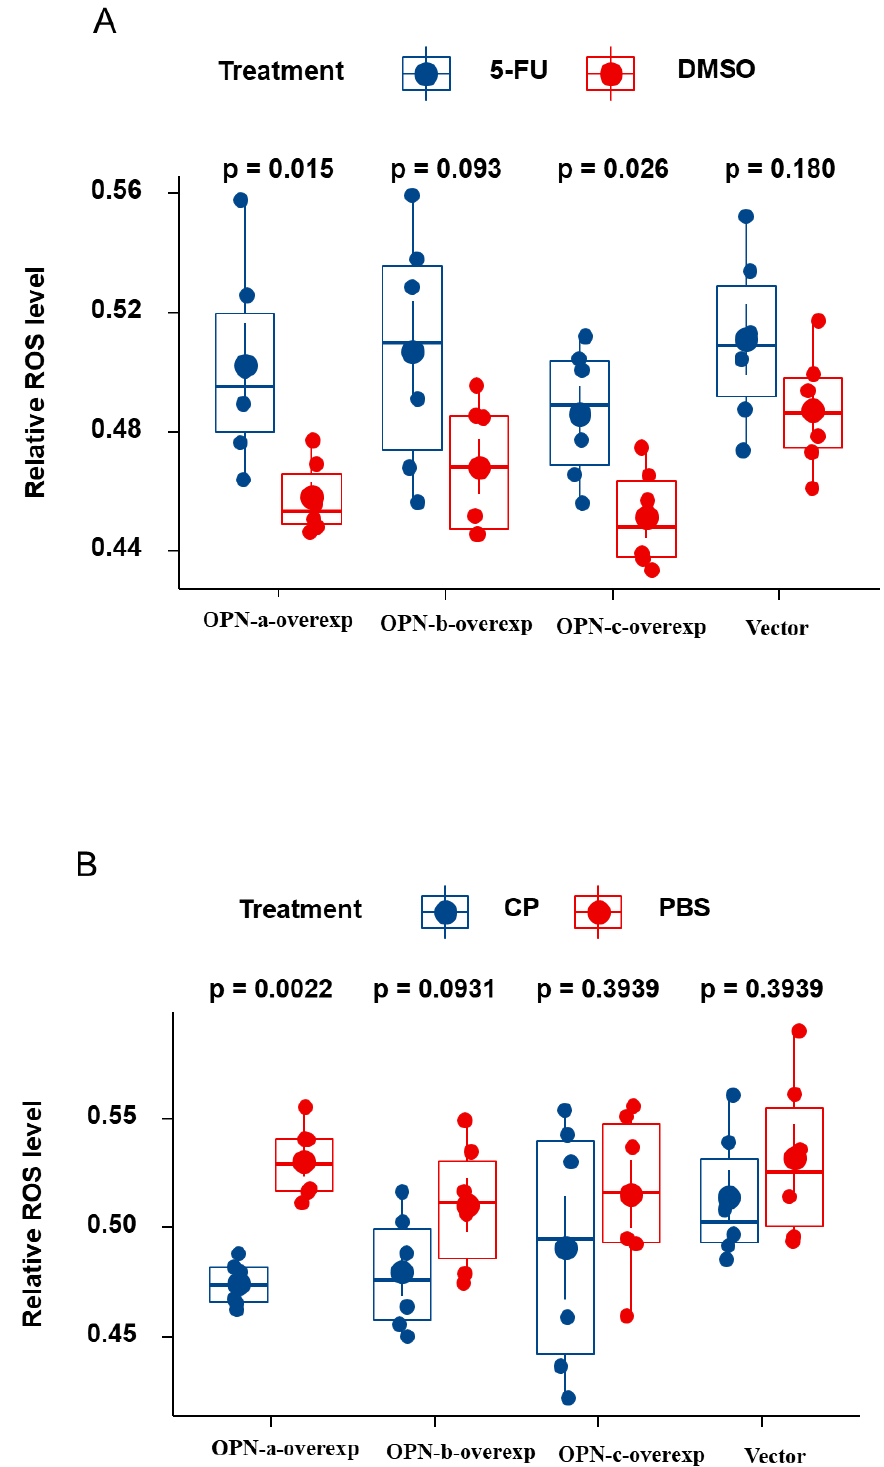
Figure 4. Effect of the OPN variants on the Cellular Reactive Oxygen Species (ROS) produced by gastric cells in response to chemotherapeutic drugs. ( A ) 5-Fu and its DMSO control. ( B ) Cisplatin (CP) and its PBS